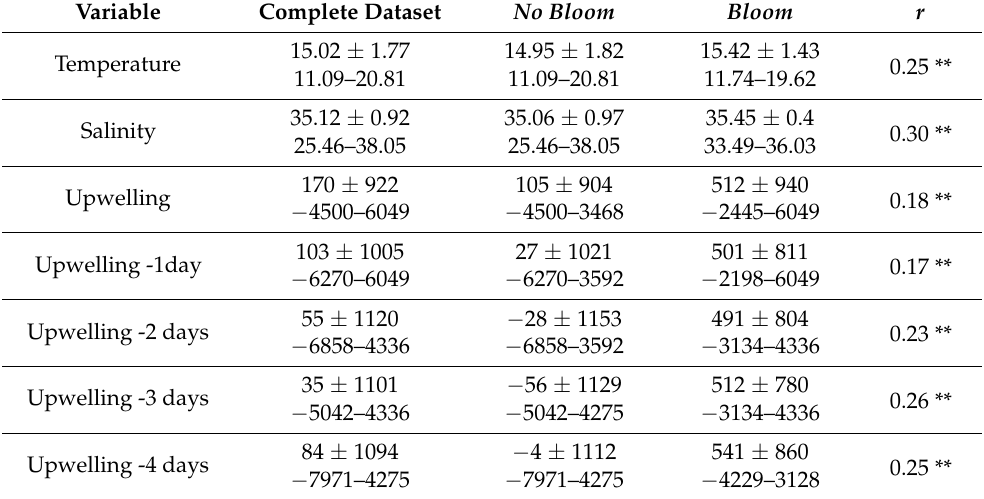
Table 5. Basic statistics (average ± standard deviation, minimum – maximum) of each numerical variable for the complete dataset (combination A) and for no bloom and bloom classes, as well as the Pearson correlation coefficient ( r ) between each variable and Pseudo-nitzschia spp.